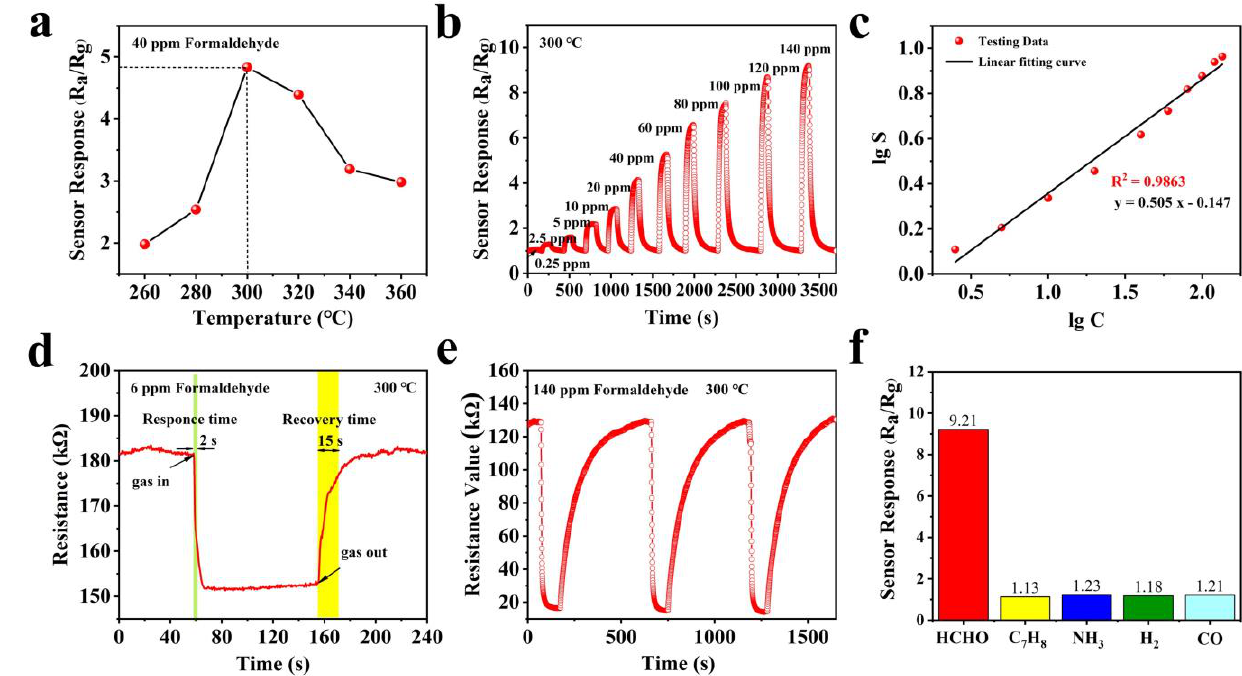
Figure 4. ( a ) Response of SnO 2 nanoflowers sensor to 40 ppm formaldehyde at different tempera- tures. ( b ) Response of SnO 2 nanoflowers sensor to formaldehyde gas at different concentrations. ( c ) The good linear plots of the SnO 2 nanoflowers response versus formaldehyde concentration. ( d ) Response/recovery curve of SnO 2 nanoflowers sensor for 6 ppm formaldehyde. The response and recovery time to 6 ppm HCHO are 2 and 15 s, respectively. ( e ) Three-time repeatability of SnO 2 nanoflowers sensors. ( f ) The selectivity of SnO 2 nanoflowers sensors for formaldehyde (HCHO), toluene (C 7 H 8 ), ammonia (NH 3 ), hydrogen (H 2 ), and carbon monoxide (CO).